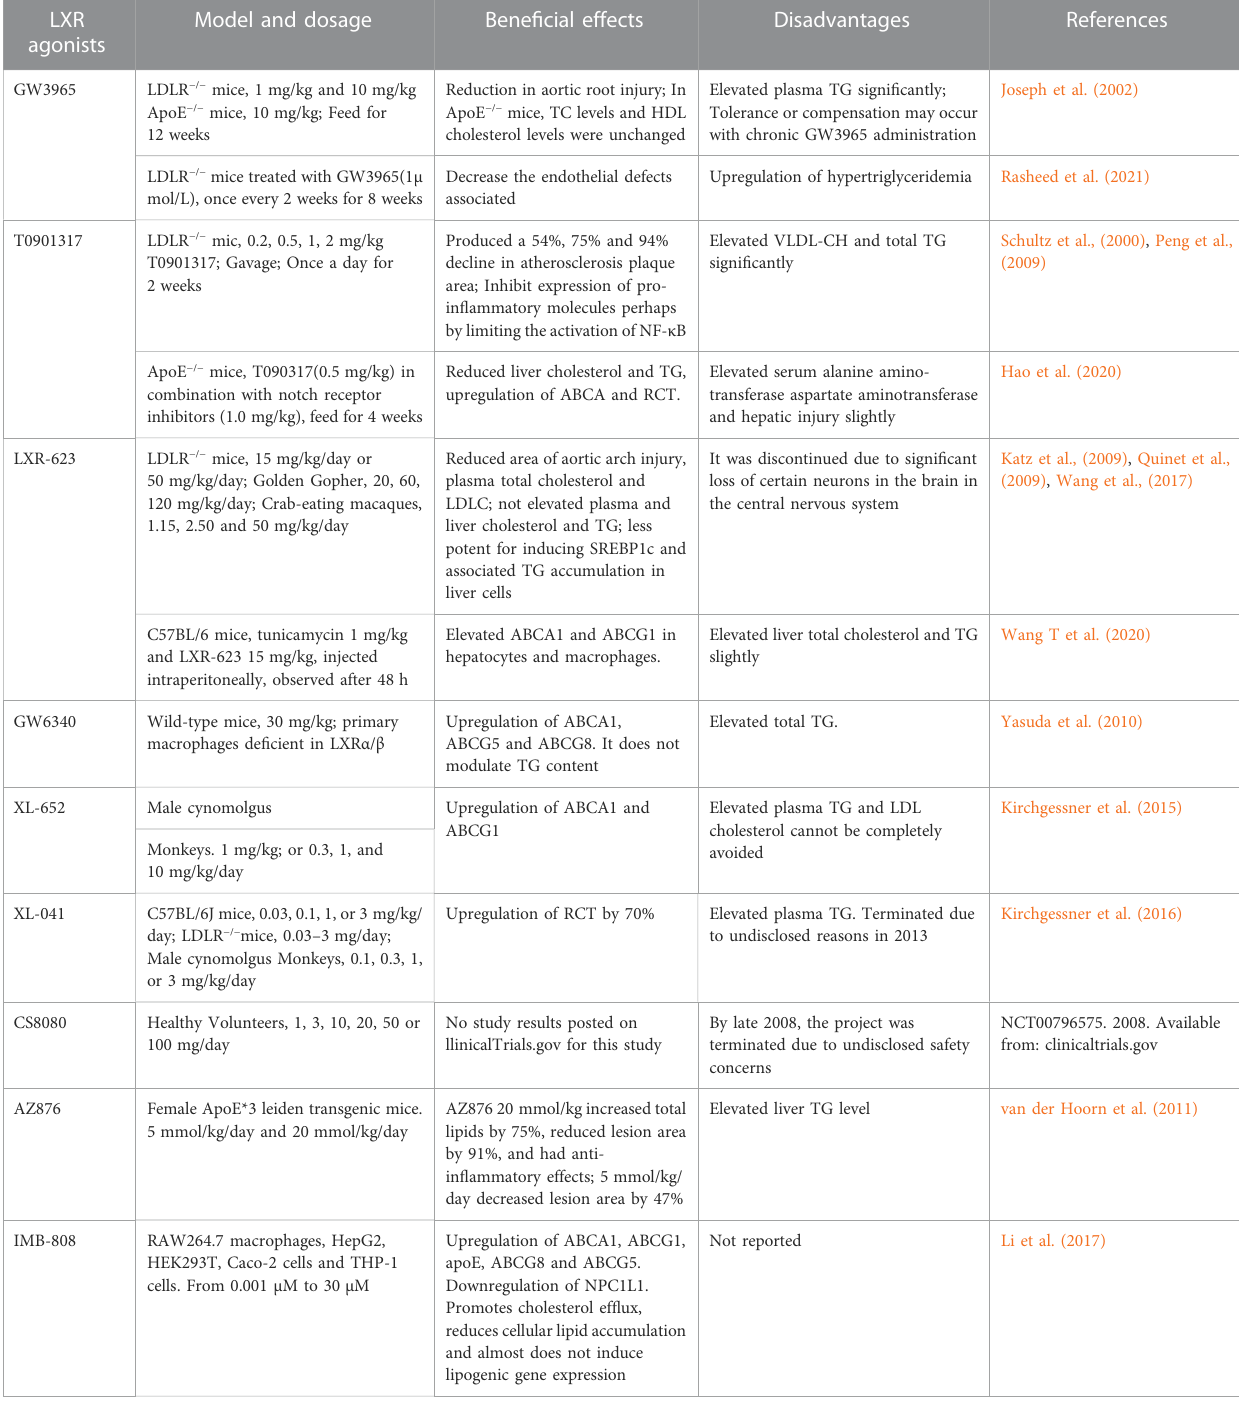
TABLE 1 Summary of synthetic LXR agonists for therapy of